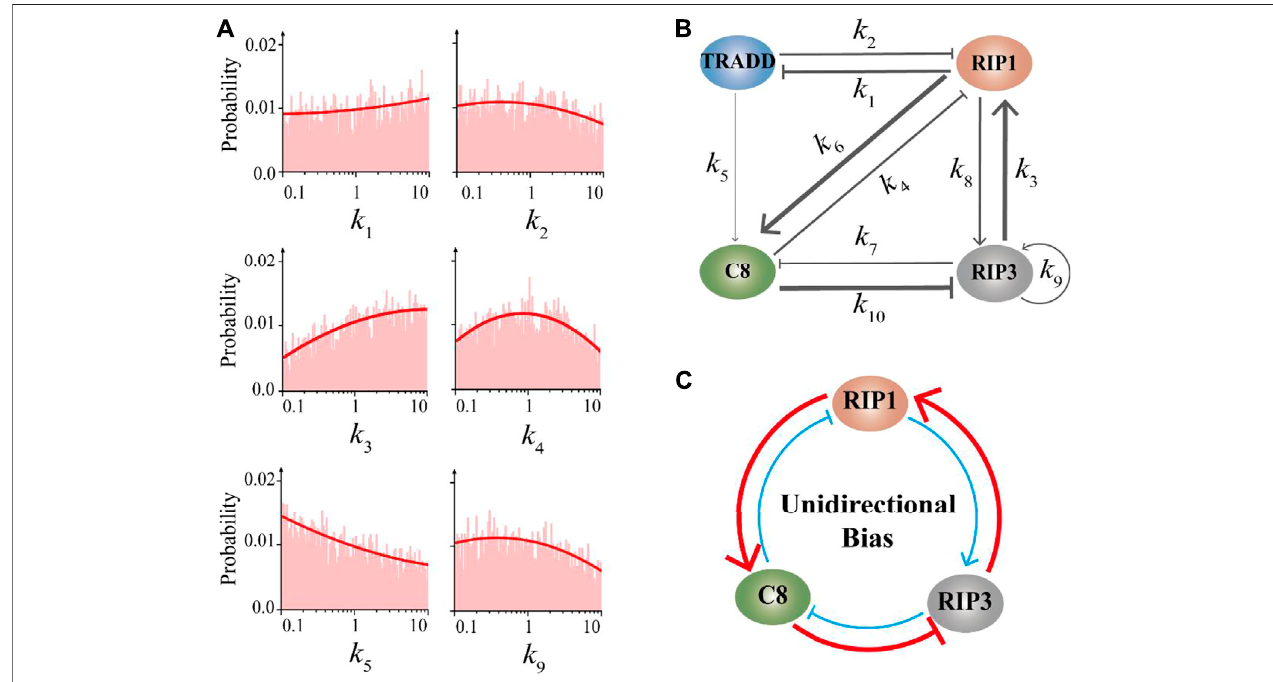
FIGURE 4 | The unidirectional bias within the CNS circuit. (A) The parameter distributions of the other six parameters in the core module of the CNS circuit except that shown in Figure 3B . (B) Schematic diagram ofthe interaction strength within the CNS circuit for inducing the high probability ofoscillation. The thickness of the line represents the optimal value in the parameter distribution. (C) The unidirectional bias captured by the feedback loops formed by RIP1, caspase-8, and RIP3. Thick red lines indicate strong fast interaction, while thin blue lines indicate weak slow interaction.